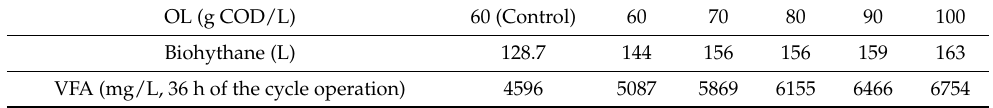
Table 2. Cumulative biohythane and VFA production recorded at different OLs.